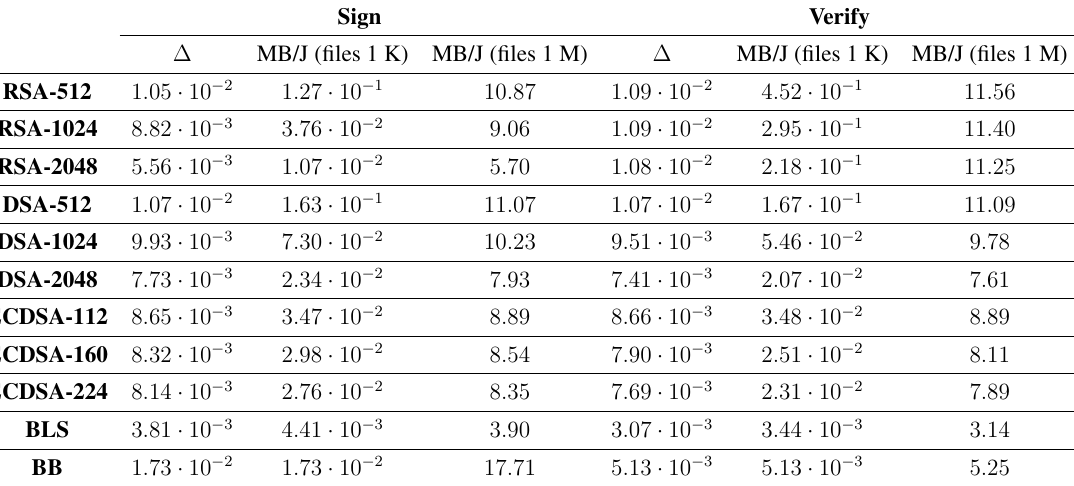
Table 7. Energy costs (MB/J) of digital signature in